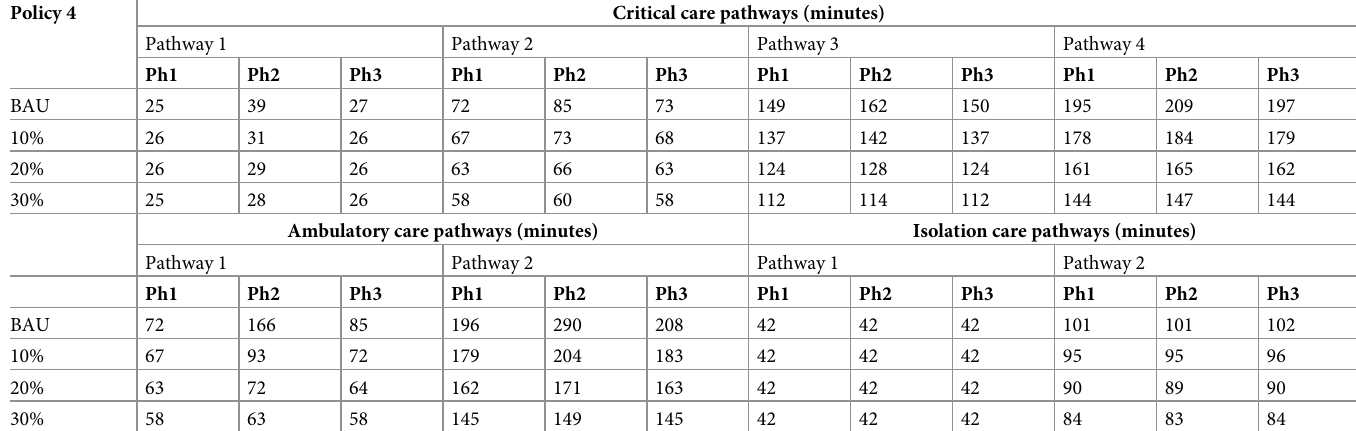
Table 4. ALOS ED patients face depending on care venue, patient pathway, arrival time for combined interventions policy where all the interventions—i.e., co-loca- tion, capacity of doctors, and observation ward and laboratory—are implemented